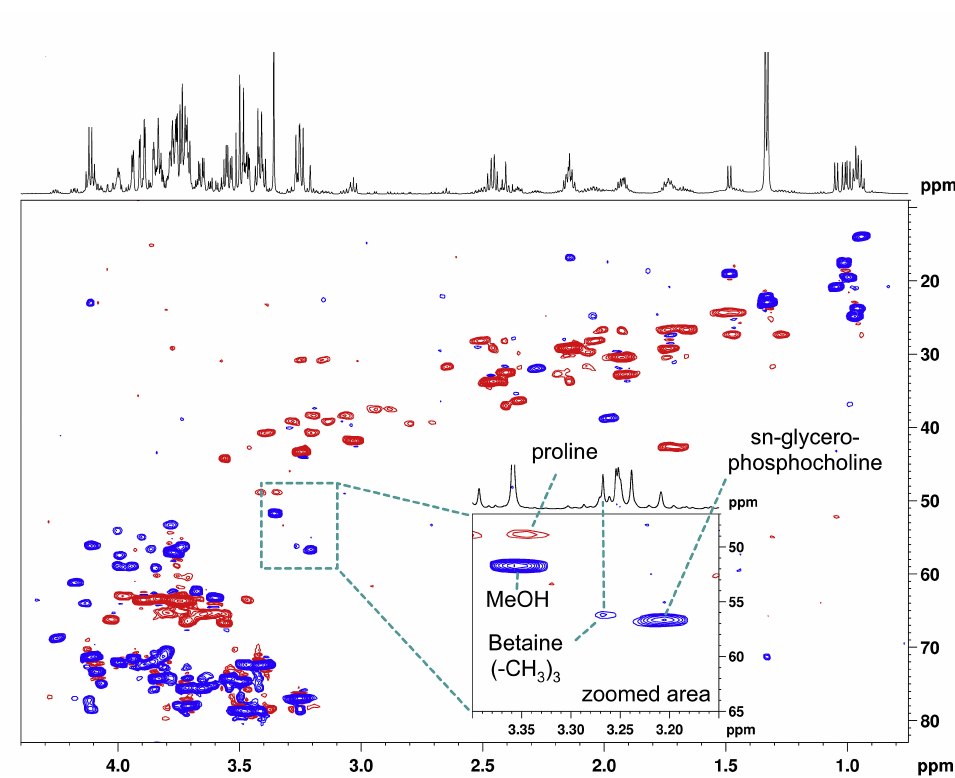
Figure A3. 1 H- 13 C 2D HSQC experiment to identify TMAO and betaine organic compounds of a biological matrix. Figure reprinted from Ref. [145] under the terms of the Creative Common CC-BY